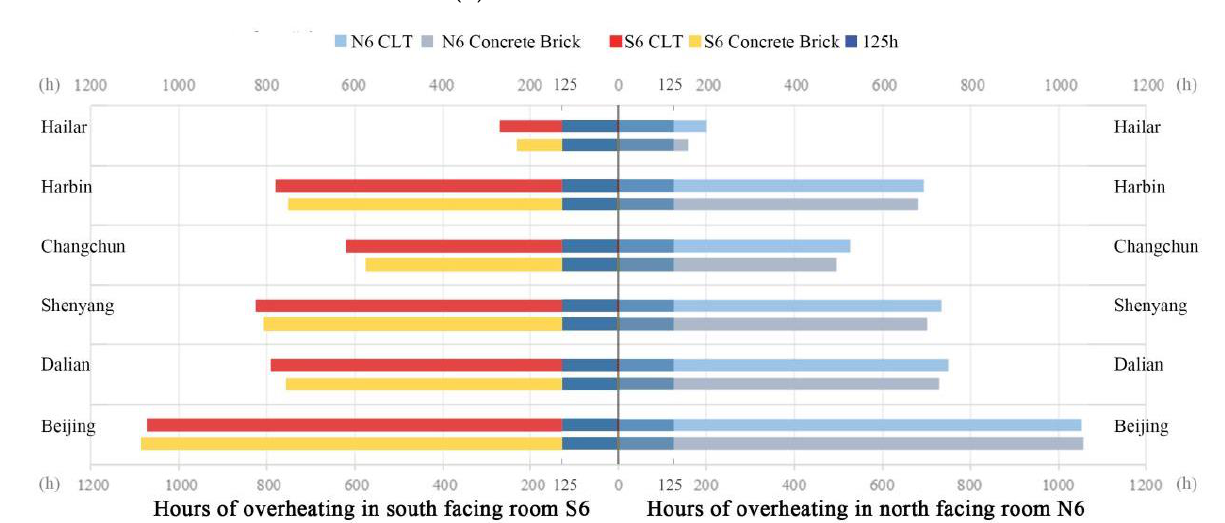
Figure 8. Number of hours > 25 ◦ C or > 28 ◦ C in six cities according to CIBSE TM52. The results also show a significant difference in the number of overheating hours between the south-facing room and the north facing room in the severe cold and cold regions. Taking 25 ◦ C as the standard, the percentage of overheating hours during working time on the south side can be 19–105 h more than that on the north side. Taking 28 ◦ C as the standard, the percentage of overheating hours on the south side of the room can be 19–113 h more than that on the north side. These differences will vary with different climatic conditions and different envelope